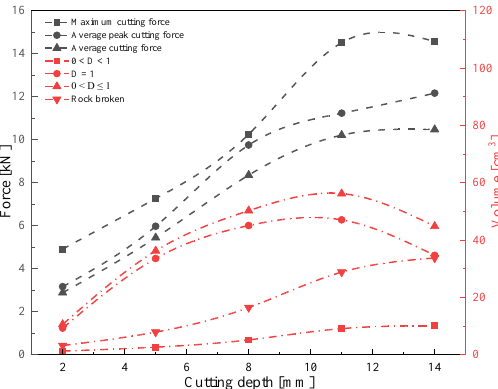
Figure 15. The rock damage and rock volume with various cutting depths.